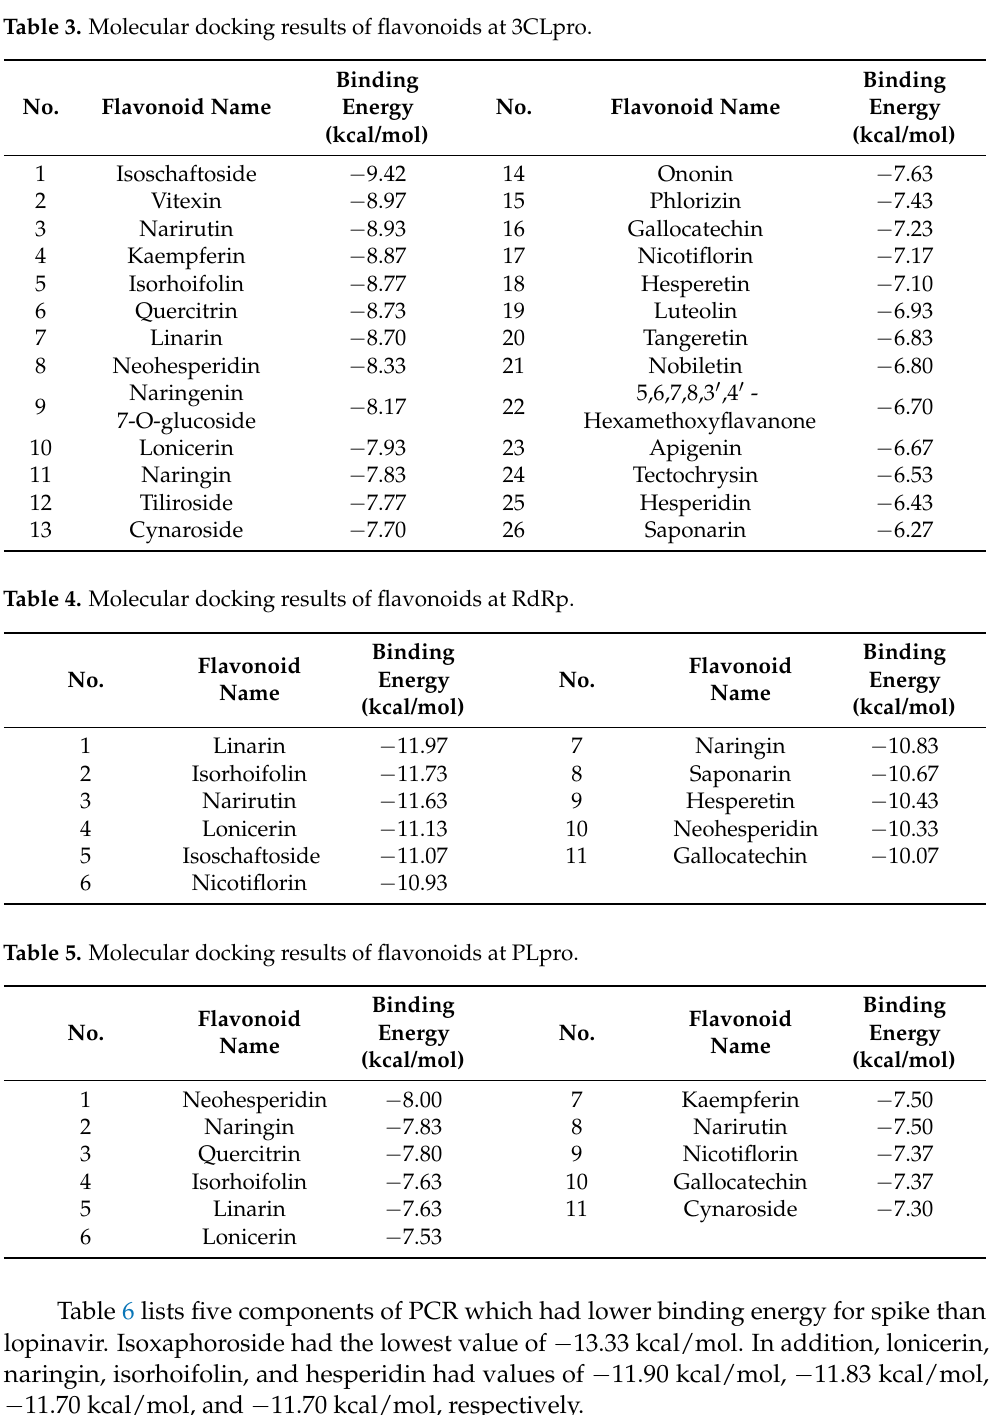
Table 3. Molecular docking results of flavonoids at 3CLpro.